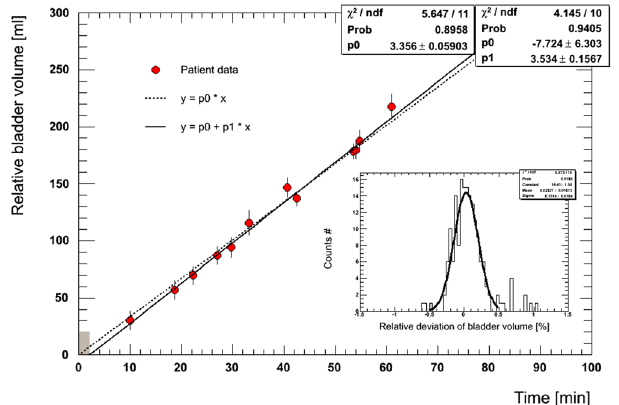
Figure 1. Typical example of the urinary inflow together with the linear fit. The urinary inflow rate was calculated as the slope of the linear fit